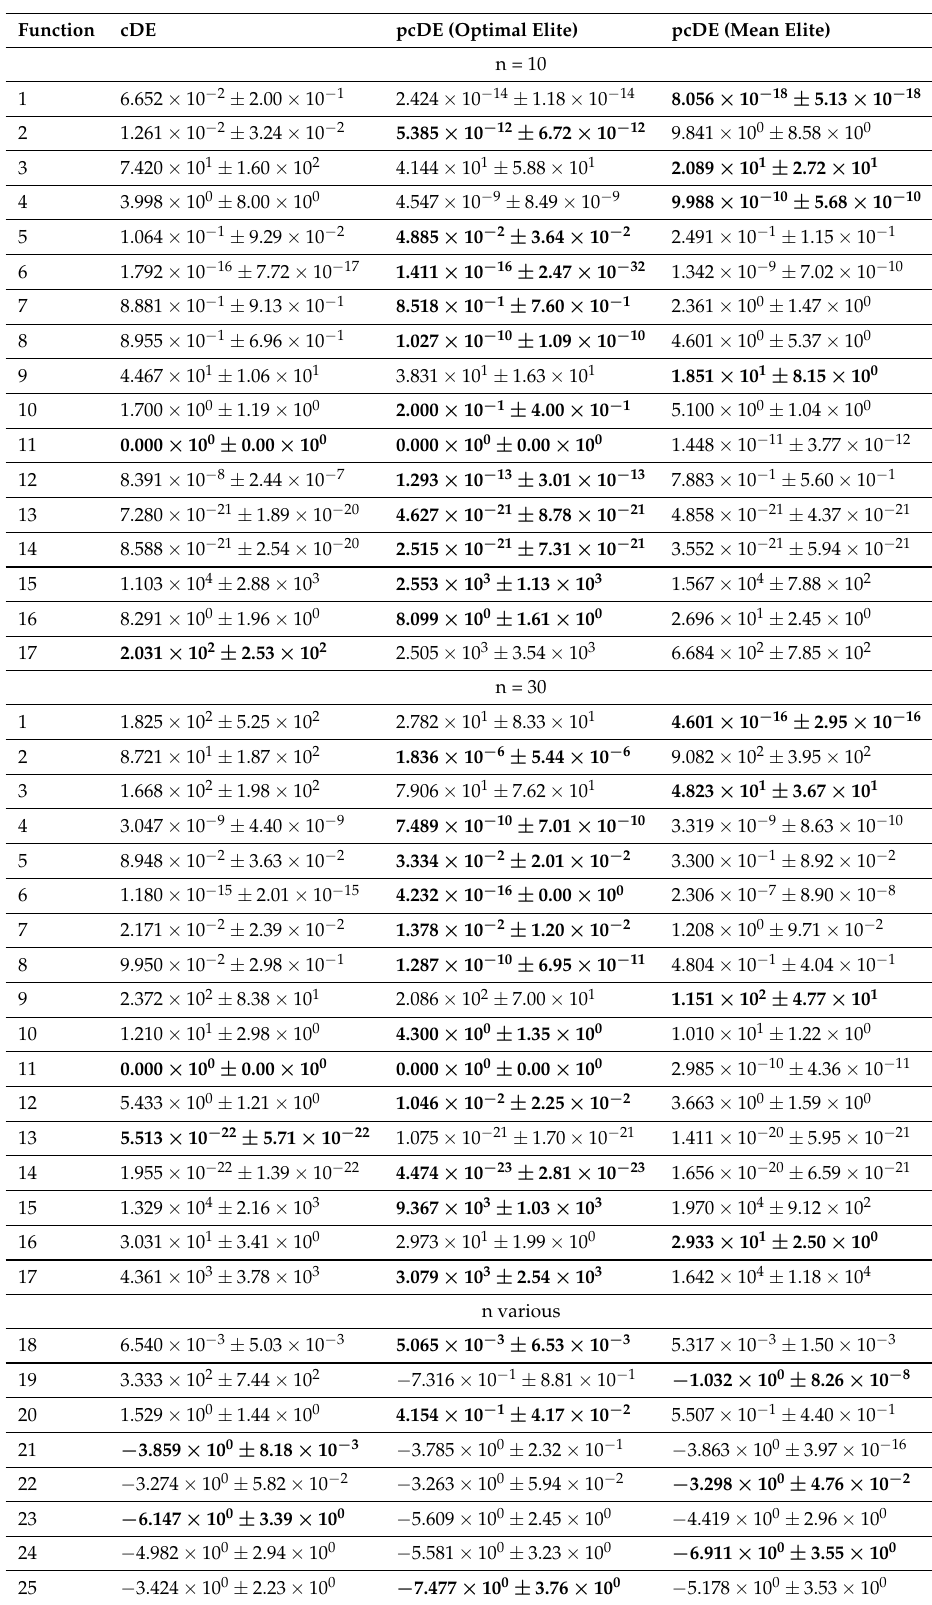
Table 1. Final average fitness ± standard deviation(persistent